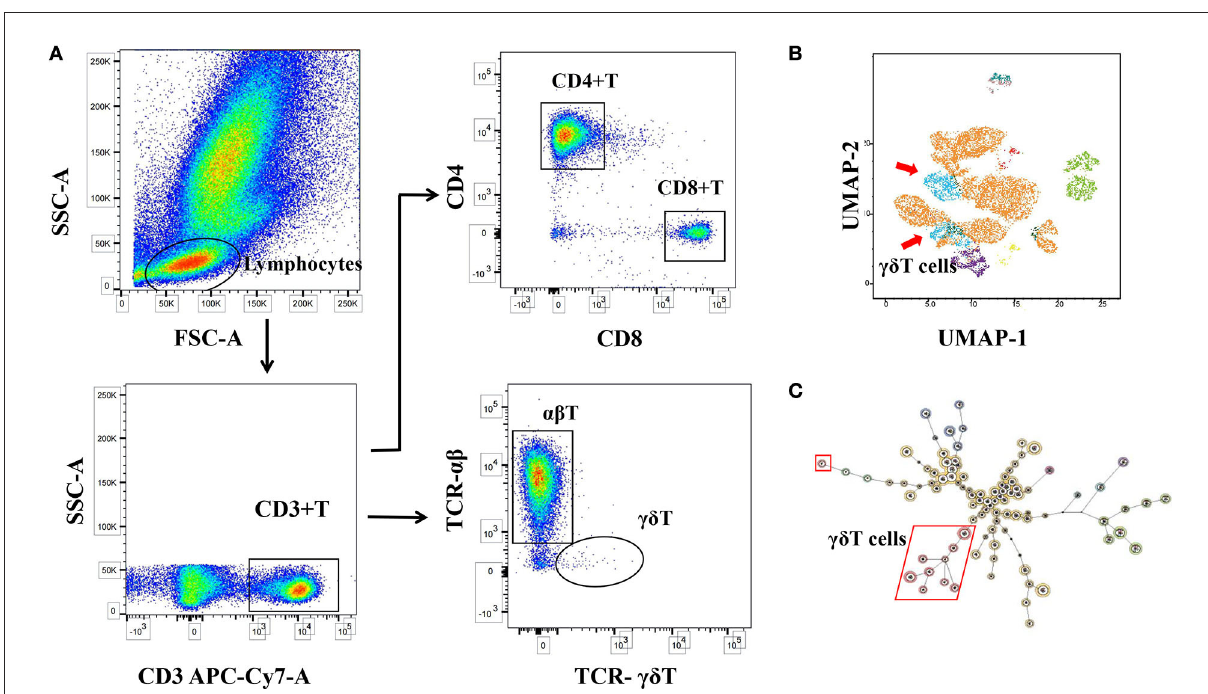
FIGURE2 Logic diagram for immune cell analysis. (A) Circle gate logic of T-cell subsets detected by flow cytometry. (B) Maps of self-organizing and consistent hierarchical clustering of different T-cell subsets (FlowSOM). (C) Dimensionality reduction profile of immune cells (Uniform Manifold Approximation and Projection, UMAP). γδ T cell differences were found to be